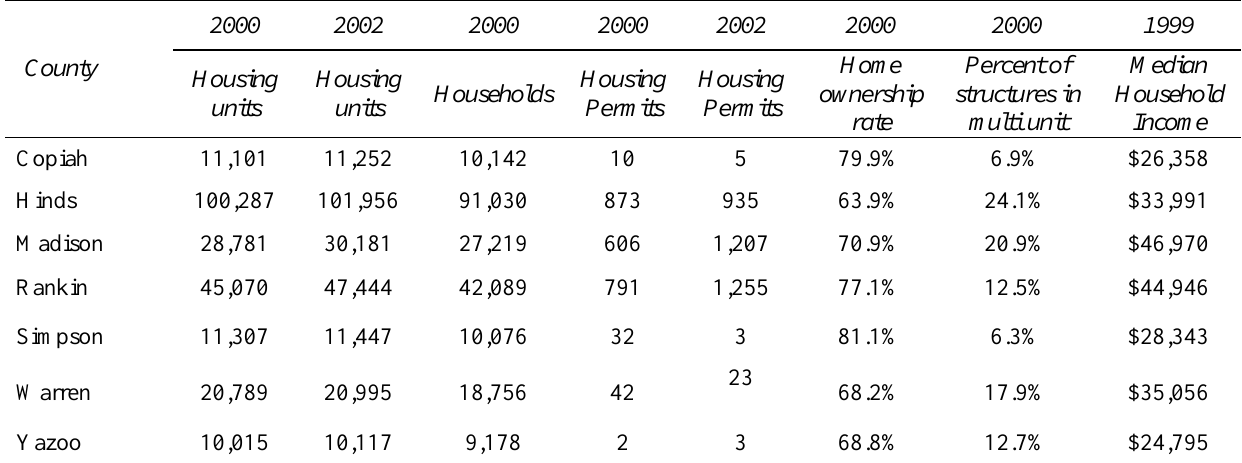
Table 3: Selected Indicators on Housing